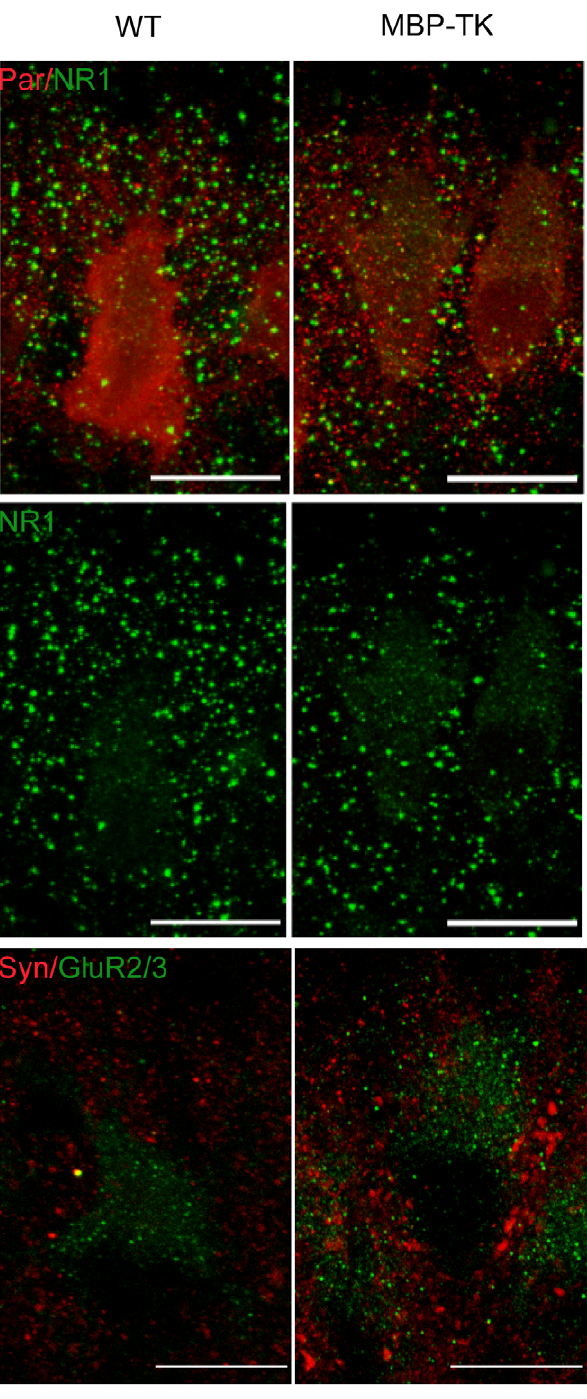
Figure 5. Oligodendrocyte ablation at P1 leads to modifica- tions of glutamate receptors levels in Purkinje neurons. Double immunostaining were performed in animals treated only at P1 and analyzed at P5 with antibodies directed against parvalbumin (Par, red), NMDAR subunit NR1 (green), GluR2/3 and synaptophysin (syn). Scale bar: 20 m m.